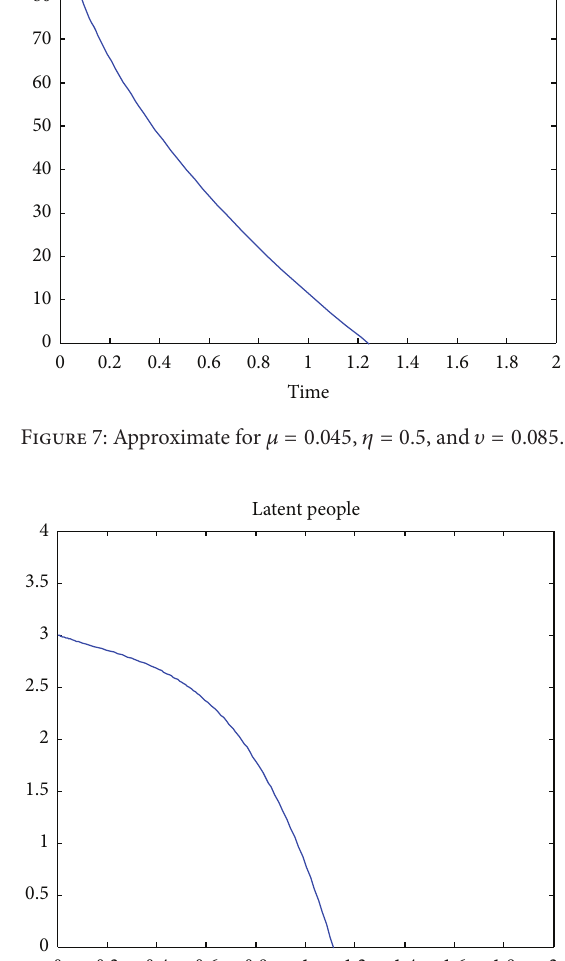
Figure 5: Approximate for 𝜇 = 0.45 , 𝜂 = 0.7 , and 𝜐 = 0.85 .